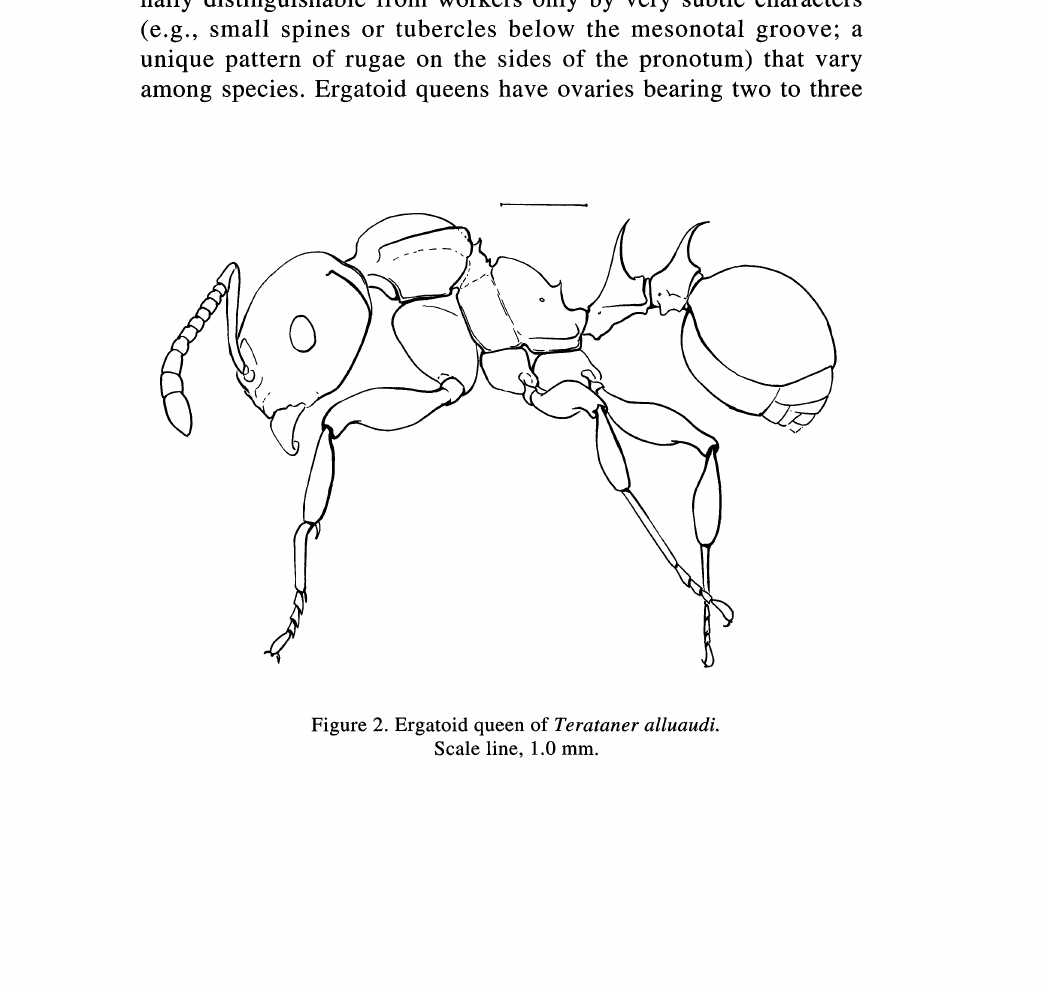
Figure 2. Ergatoid queen of Terataner alluaudi. Scale line, 1.0